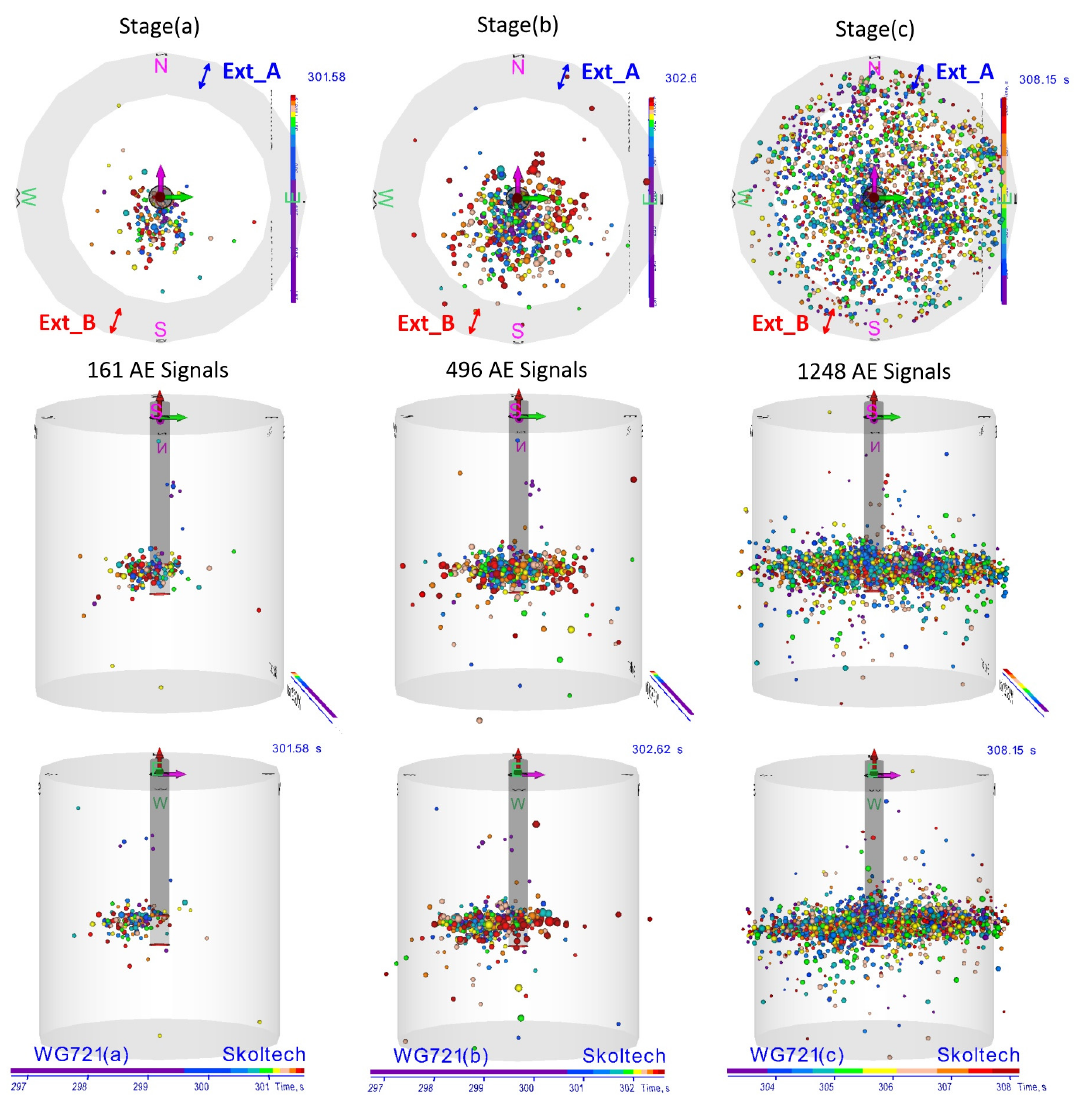
Figure 15. Three orthogonal projections of positions of AE signals in the space of the WG-721 sam- ple.